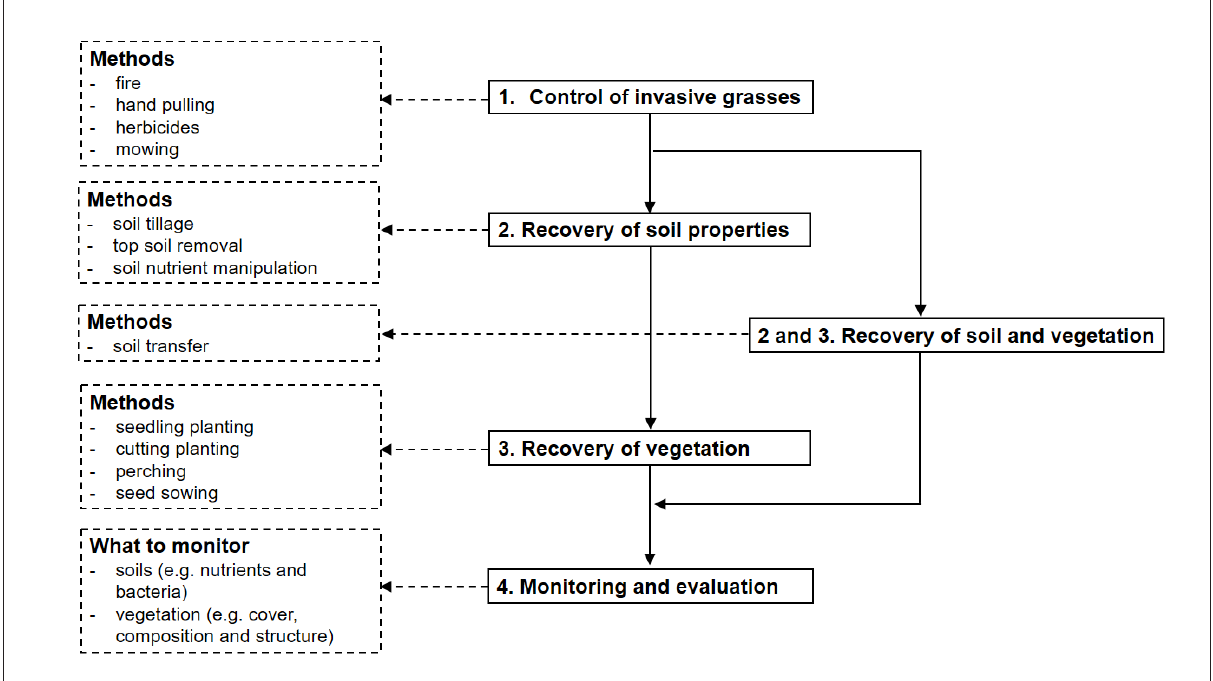
Figure 1: The conceptual framework of the suggested integrated ecological restoration approach for